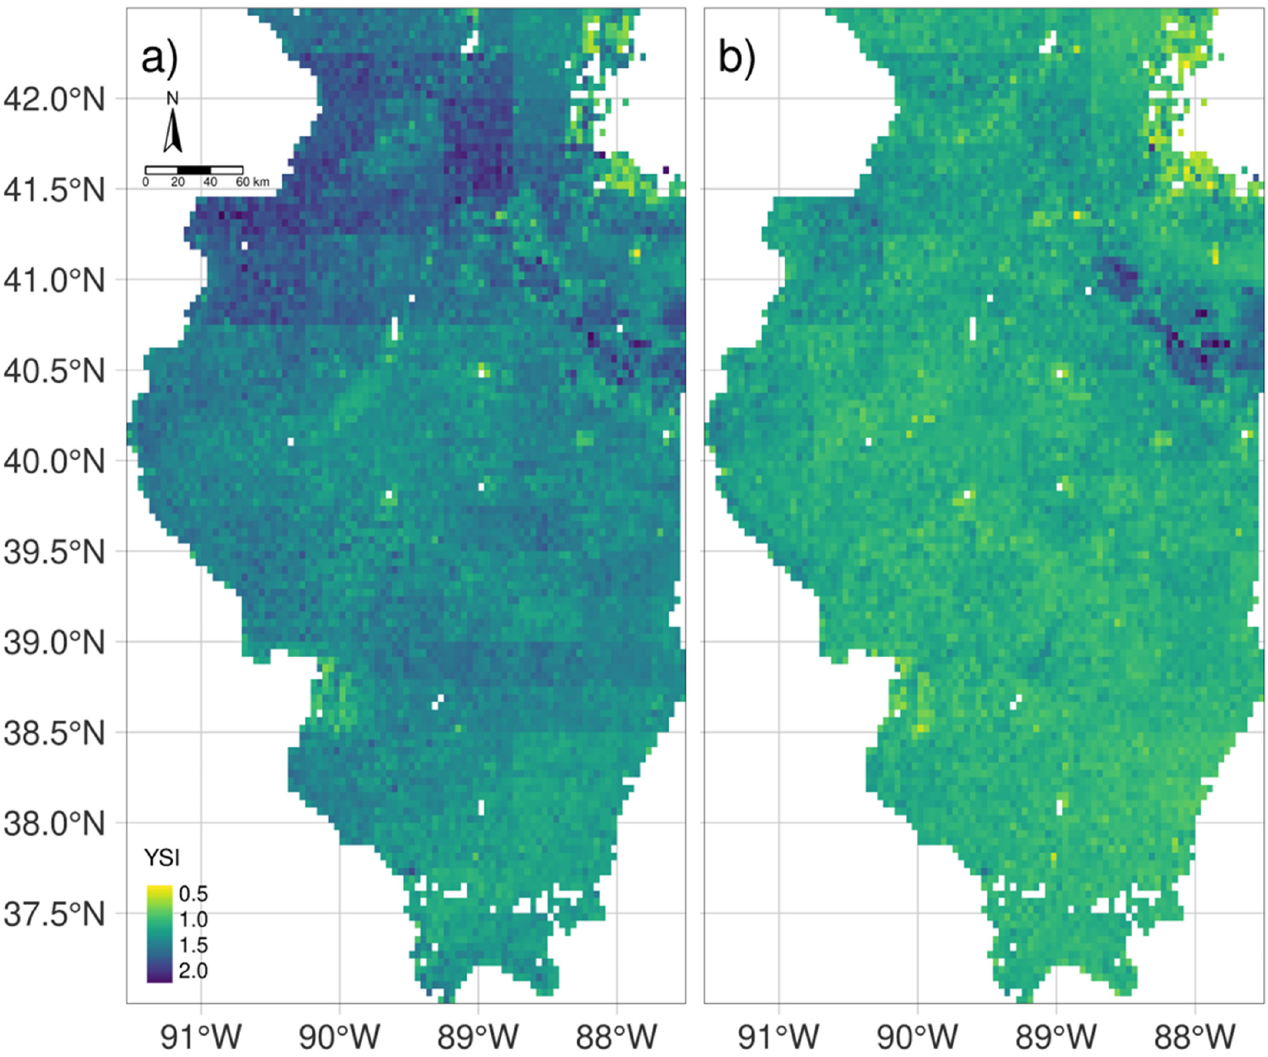
Figure 8. The ratio of coefficient of variation for ( a ) corn-corn to corn-rye-corn-rye and ( b ) corn- soybean to corn-rye-soybean-rye expresses as yield stability index (YSI) at each pixel when aggregated over the study period.